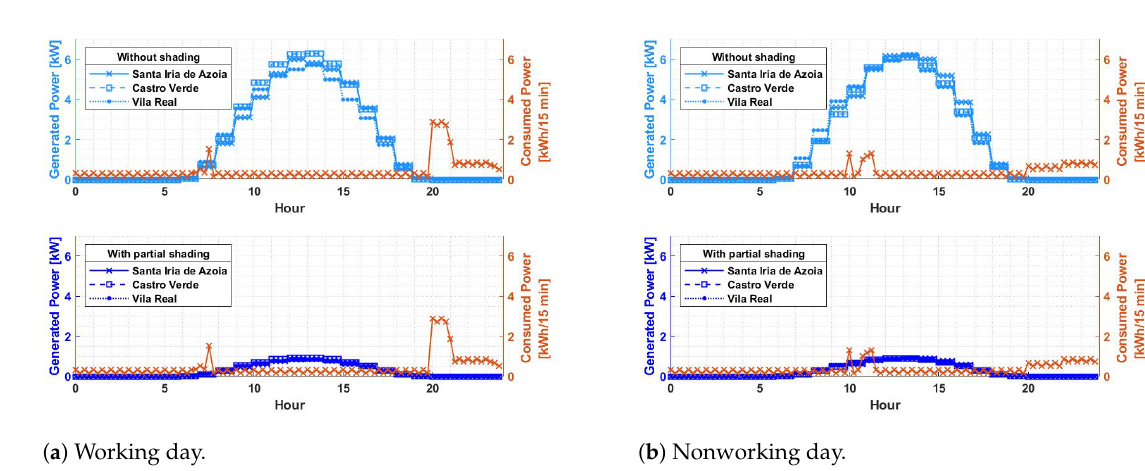
Figure 10. Generation and consumption curves on the two significant days of August for CsPbI 3 QDs technology.